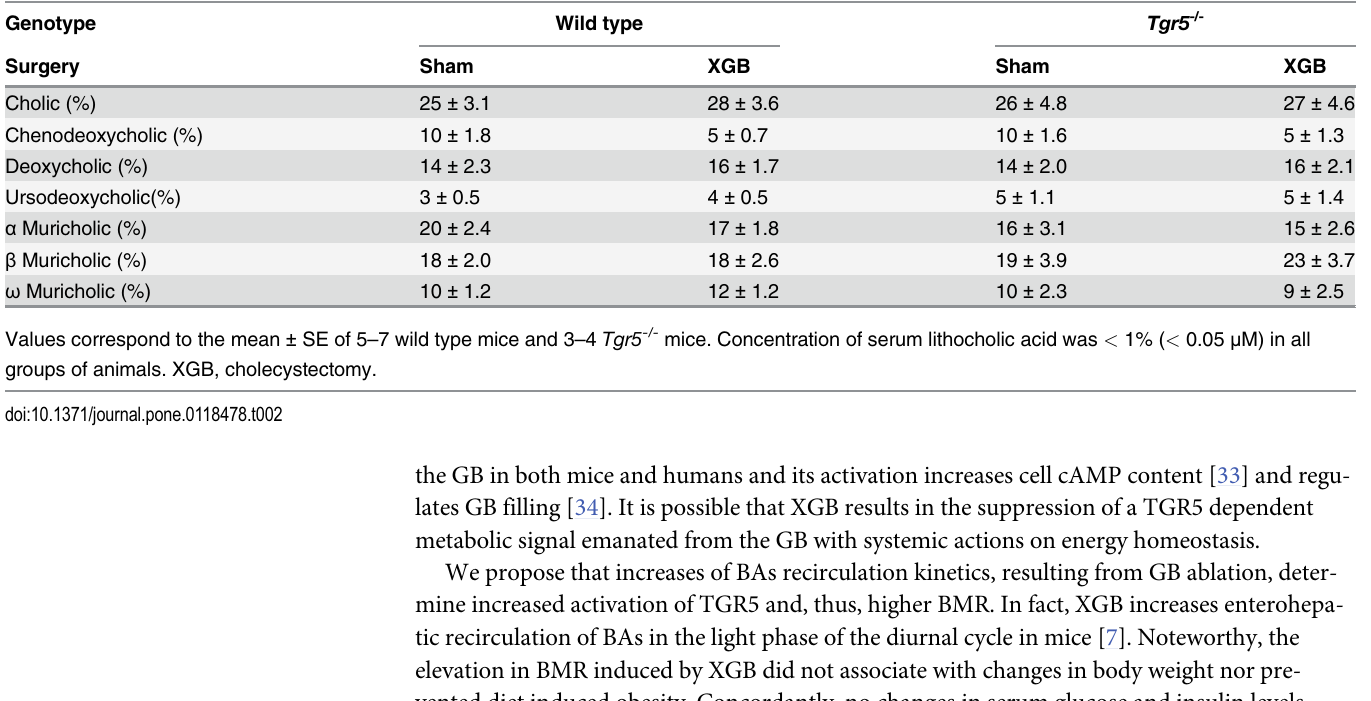
Table 2. Serum BAs composition in wild type and Tgr5 -/- mice subjected to sham operation or cholecystectomy. Genotype